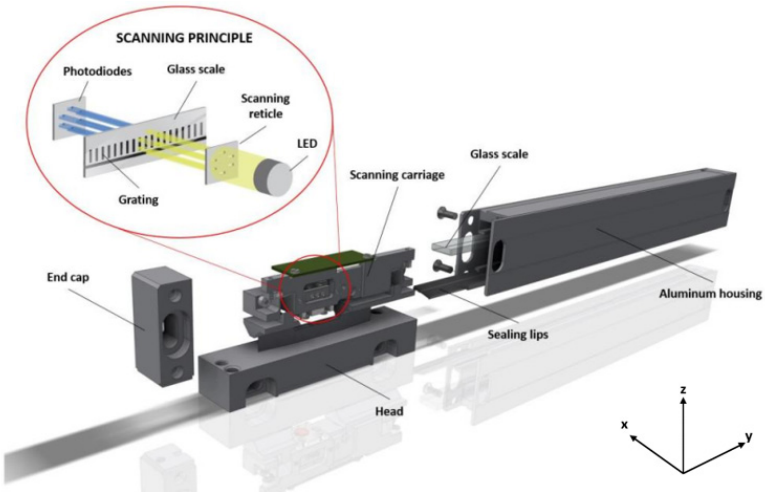
Figure 1. A scheme of the basic principle of the typical optical linear encoder.